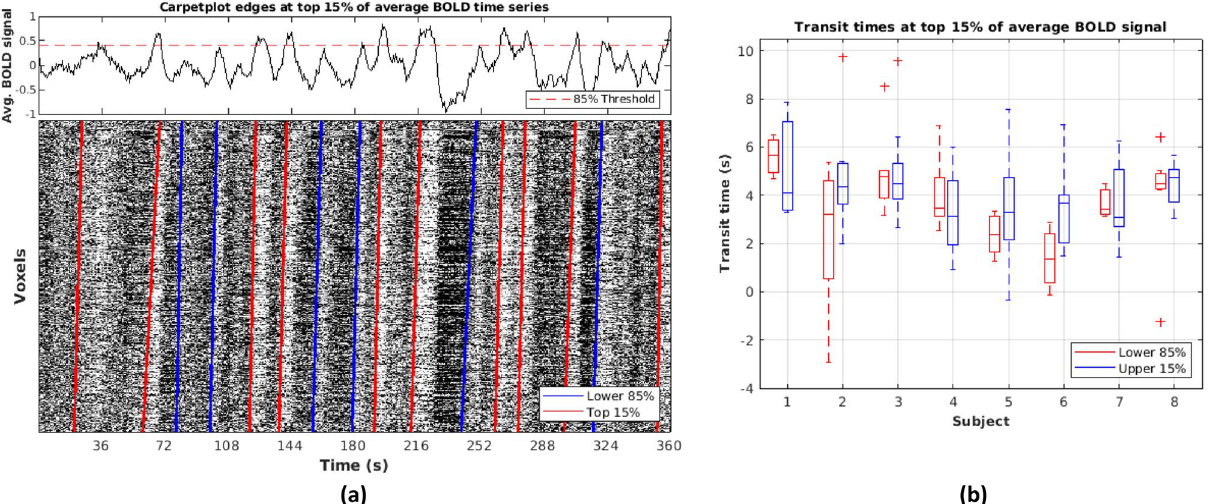
Figure 6. Separation of edges based on predicted neuronal vs. physiological association. ( a ) rs-fMRI SHAG carpet plot edges at top 15% of average BOLD time series. The upper 15% threshold was chosen based on results from Zhang et al. 27 which implied that fMRI time frames exceeding such a threshold in BOLD intensity may be related to neuronal activity. Edges were detected at rising edges (black-to-white) and designated within “Top 15%” when the edge led into a region within the top 15% of values of the average BOLD signal. ( b ) Comparing transit times for top 15% vs. lower 85% of average BOLD time series. Edges corresponding to the top 15% are those predicted to be rooted in neuronal activity, while the remaining are predicted to be physiological in nature. No significant association was found between computed transit time and assignment to neuronal or physiological categories (mixed effects linear regression model with adjustment for subjects via inclusion as a random factor, p = 0.070, computed using Stata statistical software [StataCorp LLC., College Station, TX, version 16, www. stata. com/]) 28